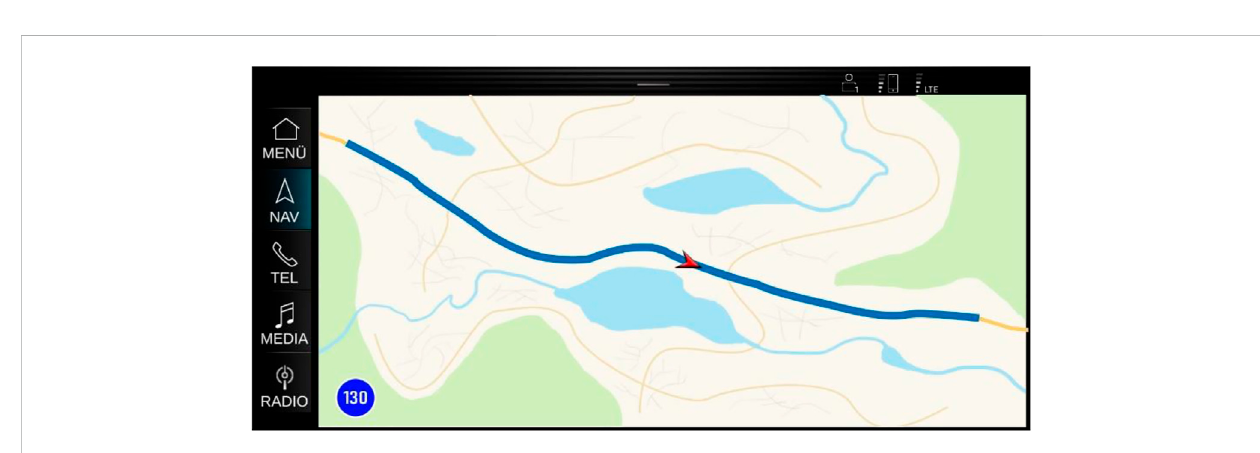
FIGURE 2 Baseline concept, providing no information on the availability